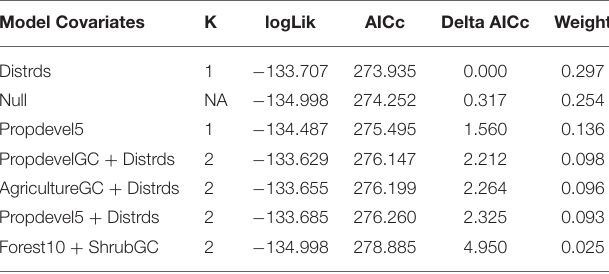
TABLE 3 | Candidate model set for C. latrans .